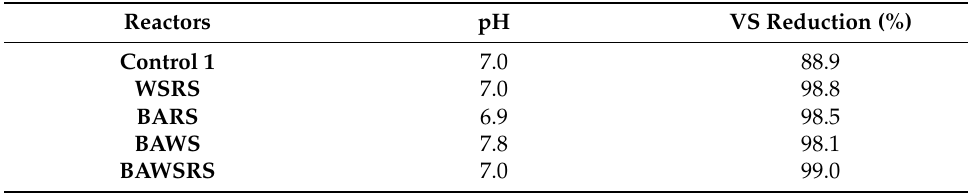
Table 2. pH and VS Reduction % after Co-digestion of S/I Ratio 1.5.